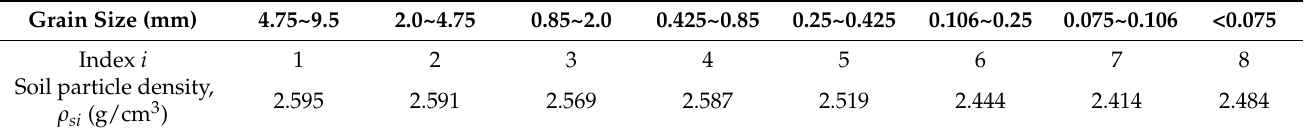
Table 3. Soil particle density of each grain size.